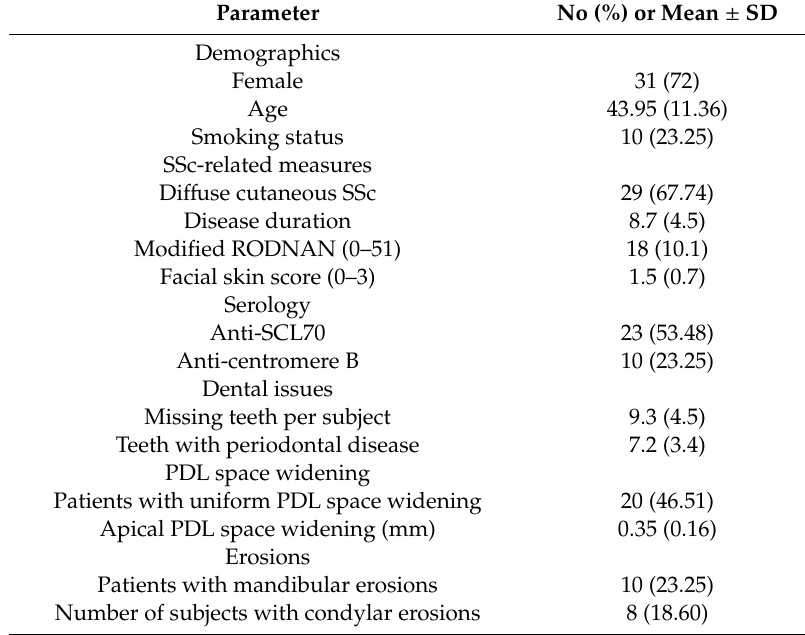
Table 1. Systemic sclerosis (SSc)-related parameters, clinical oral, and radiographic